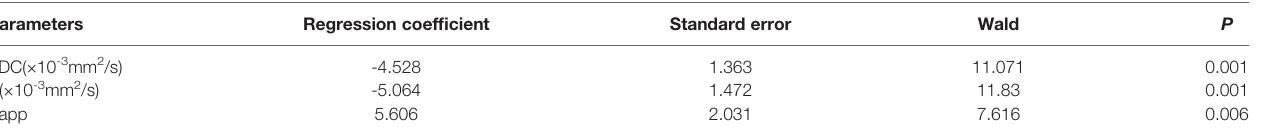
TABLE 4 | Regression analysis of ADC, D, and Kapp value.